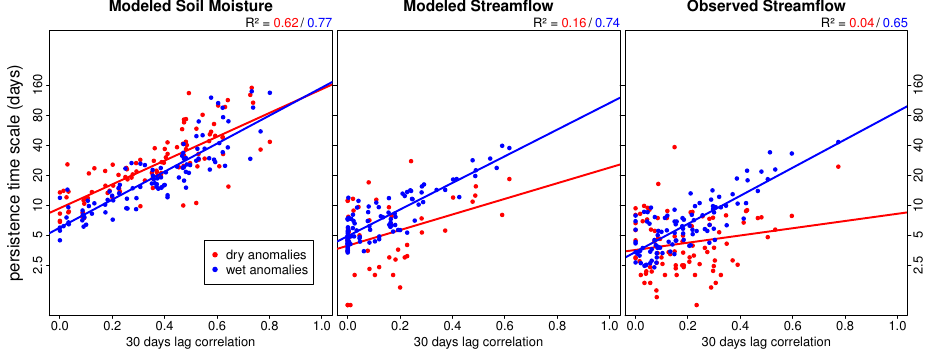
Fig. 11. Comparison of memory estimates computed as lag correlation and as persistence time scale (based on anomalies of 1.33 standard deviations from the mean) for modelled soil moisture and streamflow (left and middle) and observed streamflow (right). Red points refer to persistence time scales estimated from dry anomalies whereas blue points are derived from wet anomalies. The red and blue lines denote the respective linear least-squares fit. Note the logarithmic scale of the persistence time scale.